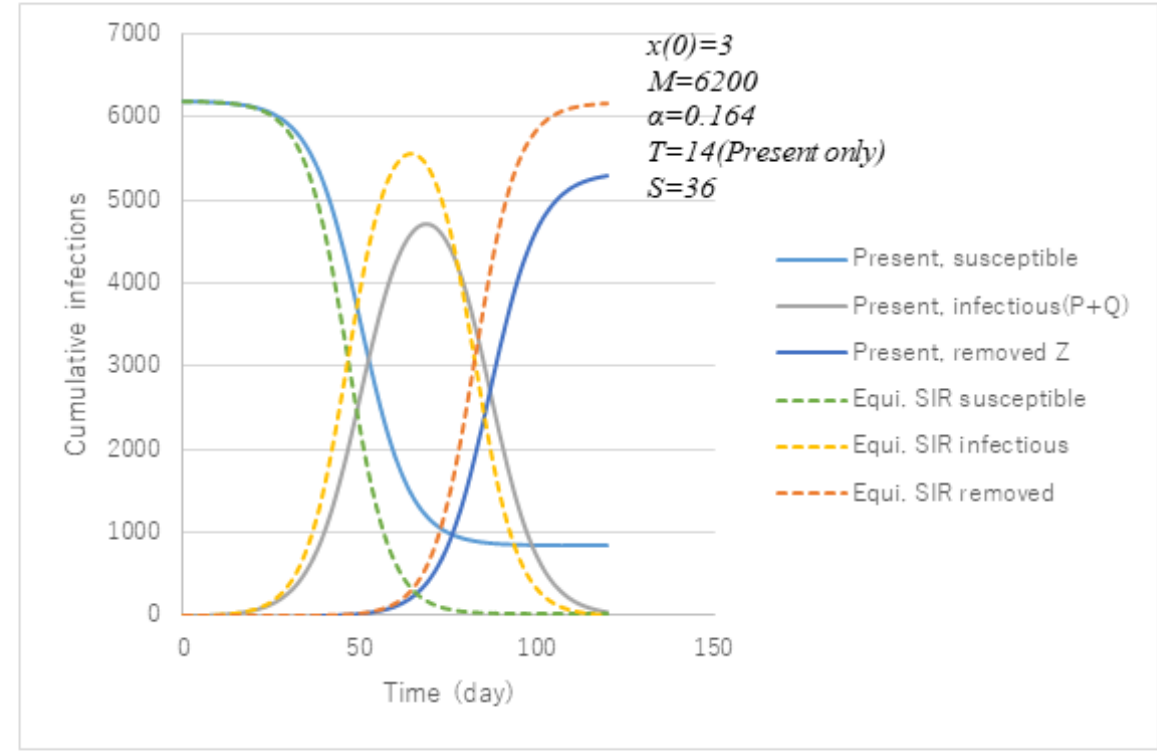
Figure 7. Comparison of simulations by the present apparent time-lag model (ATLM) with that of the standard susceptible-infectious-removed (SIR) equivalent. The results obtainable by SIR are based on equation 1 with ε =1 shown as a broken line and those by ATLM model PART1 as a solid line. Variables for infectious, removed and susceptible in SIR model correspond to those P+Q, Z and M-x, respectively in ATLM model